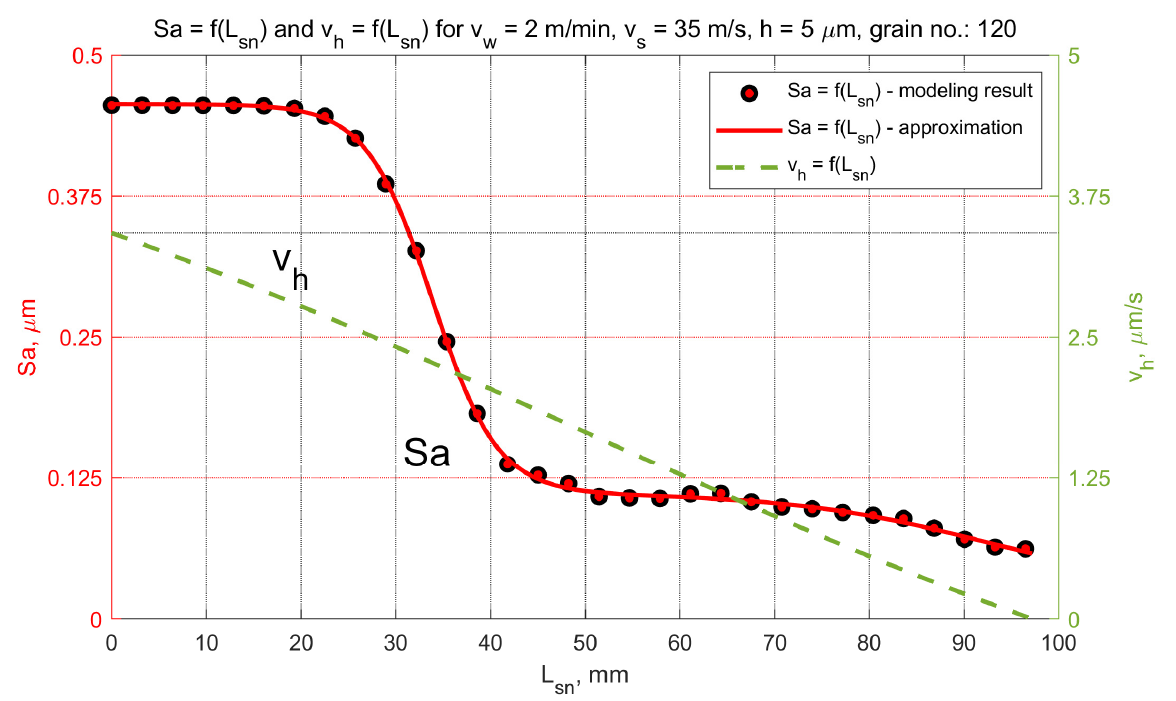
Figure 14. Changes in the Sa parameter as a function of the grinding path for a grinding depth of h = 5 µm.